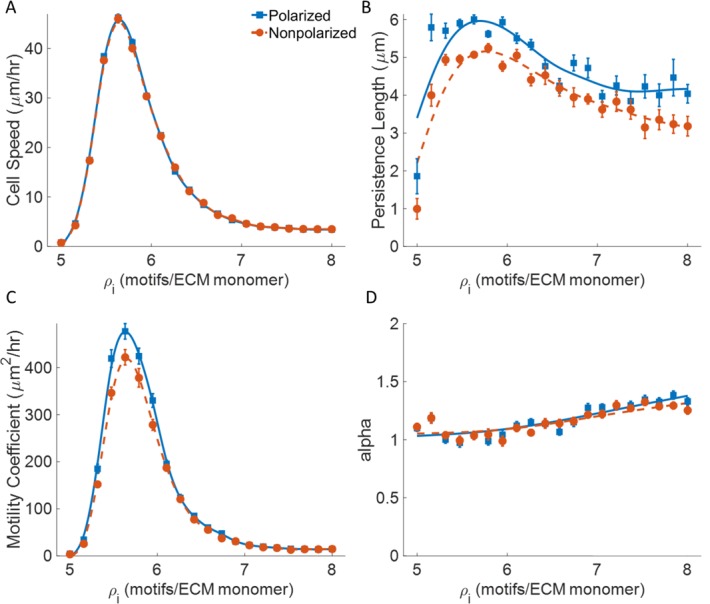
Effect of binding site density.Plots for vavg, Lp, μ, and α as a function of increasing binding site density A) Cell speed B) Random motility coefficient C) Alpha D) Persistence length. Cgel = 3.7 mg/ml, ρfiber = 1.0 x 10−3 fibers/μm3, AI = 0, and tsearch = 16s. Simulation time = 60 hrs. n = 20. Solid blue lines are polarized cells (◼), dashed red lines are nonpolarized cells (●). Error bars represent ± SEM. Splines added to emphasize trends.